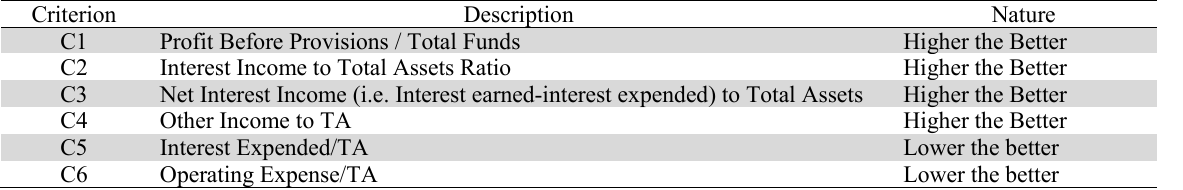
Criteria used for ranking sample banks using MCDM